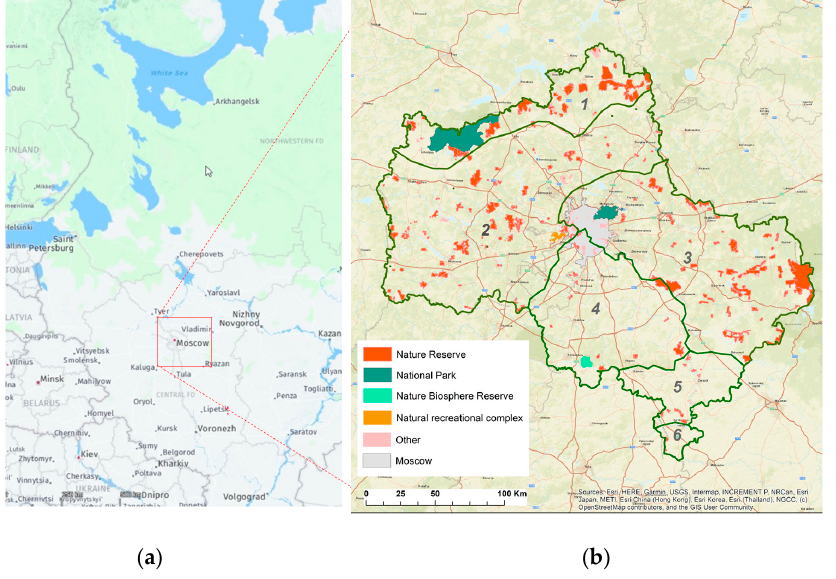
Figure 1. Study area ( a ) and the scheme of PAs in the MR ( b ) BDs: 1—LT, 2—MZ, 3—NS, 4—PK, 5—KZ, 6—S.